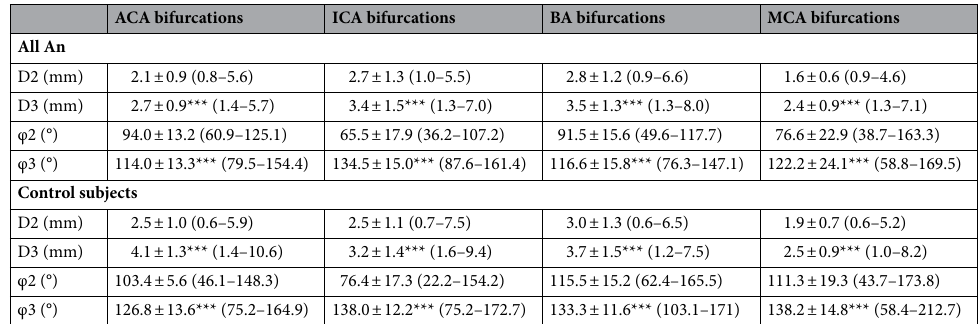
Table 2. Analysis of arterial diameter and lateral angles at major arterial bifurcations. Data are shown as mean ± standard deviation. An aneurysms, ACA anterior cerebral artery, ICA internal carotid artery, BA basilar artery, MCA middle cerebral artery. *** P < 0.001 between D2 and D3 and between φ2 and φ3. AN represents aneurysm. D2 and D3 indicate smaller and larger daughter branch, respectively. φ2 and φ3 represent smaller and larger lateral angle,